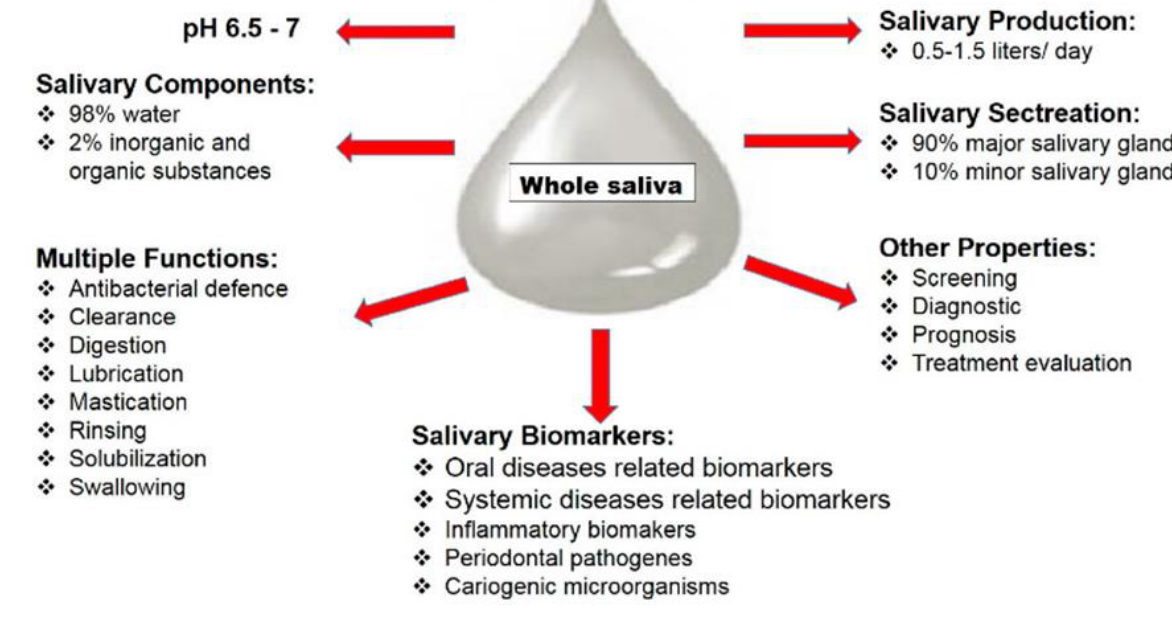
Figure 1. Saliva’s properties and composition. The human body produces, under normal conditions, between 0.5 and 1.5 L of saliva. It consists of 98% water and 2% various electrolytes, mucus, bacterial compounds and other enzymes. Saliva, like every human biofluid, performs a number of important functions related to its chemical and physical properties: rinsing, solubilization of food substances, elimination of food and bacteria, lubrication of soft tissue, bolus formation, dilution of de-bris, swallowing, speech and facilitation of chewing, coating of mucous membranes, digestion and antibacterial defense. Finally, saliva contains numerous biomarkers involved in the development of various systemic and oral diseases.